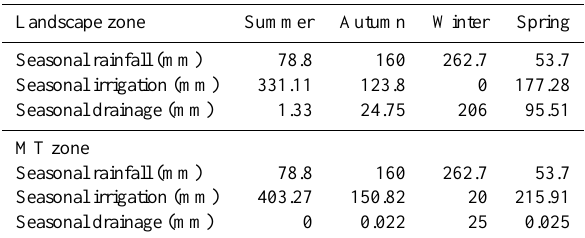
Table 1. Records of drained water from lysimeters and input water (mm).